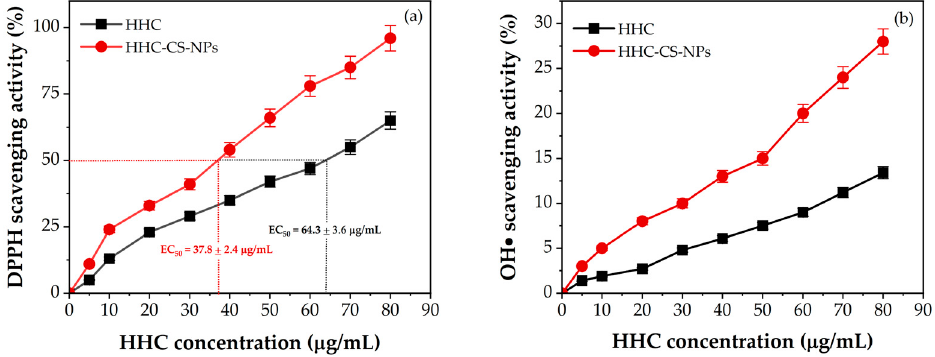
Figure 6. In vitro antioxidation activity of HHC-CS-NPs and HHC solution assessed by ( a ) DPPH radical scavenging assay and ( b ) hydroxyl radical scavenging activity ( n = 3 ) .